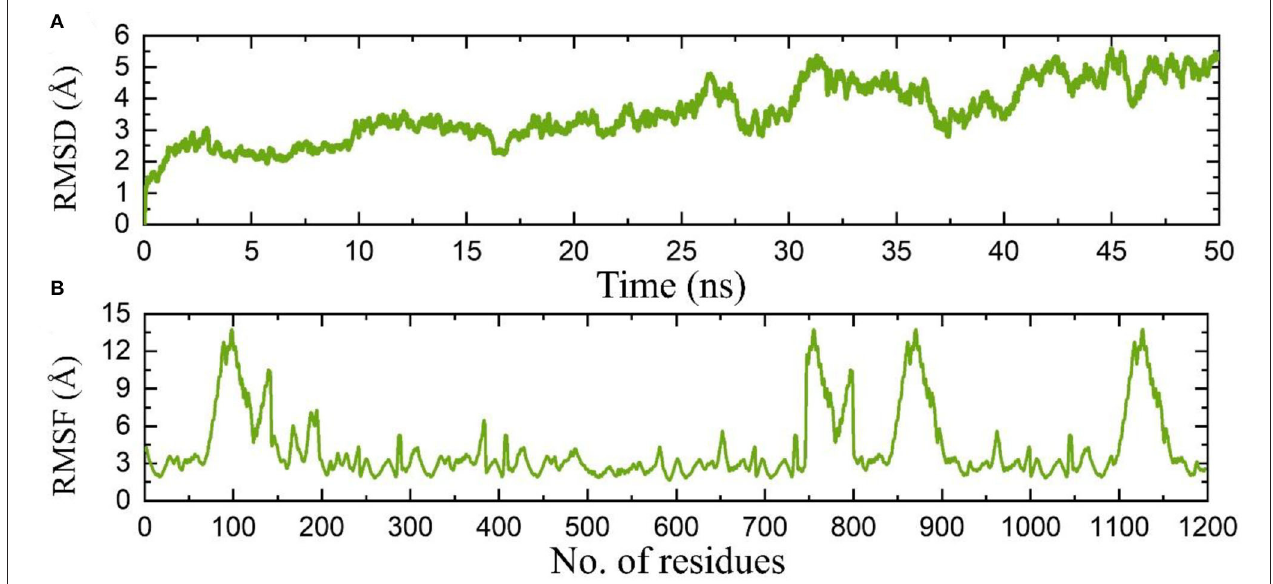
FIGURE 8 | (A) Root mean square deviation based on stability of the complex, while (B) shows the RMSF of the complex.